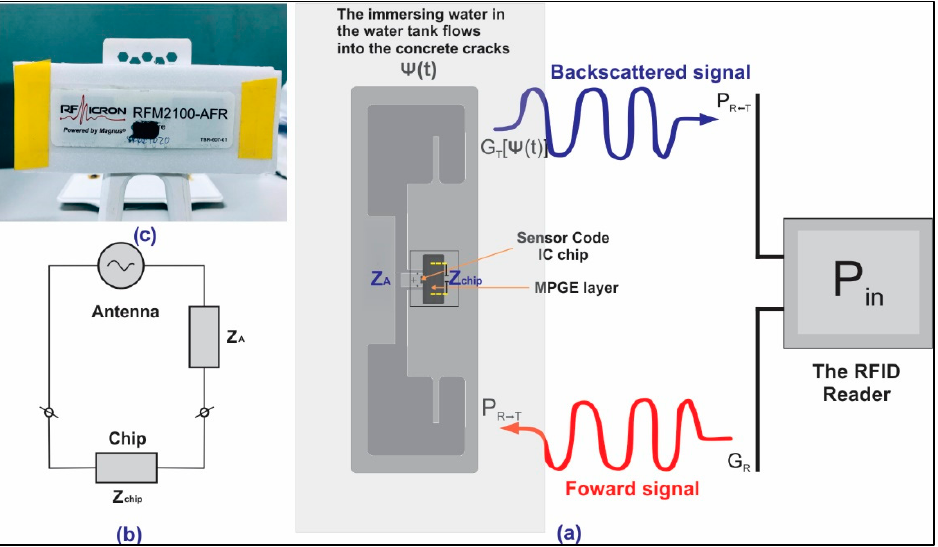
Figure 1. ( a ) Schematic principle of MPGE smart sensor system; ( b ) the equivalent circuit of the MPGE smart tag; and ( c ) coated MPGE layer on smart tag’s interdigitated capacitor.